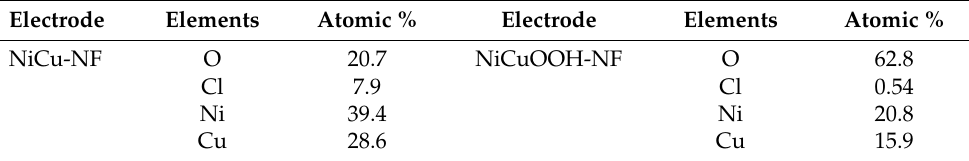
Table 1. Elemental distribution of NiCu-NF electrode and NiCuOOH-NF electrode.